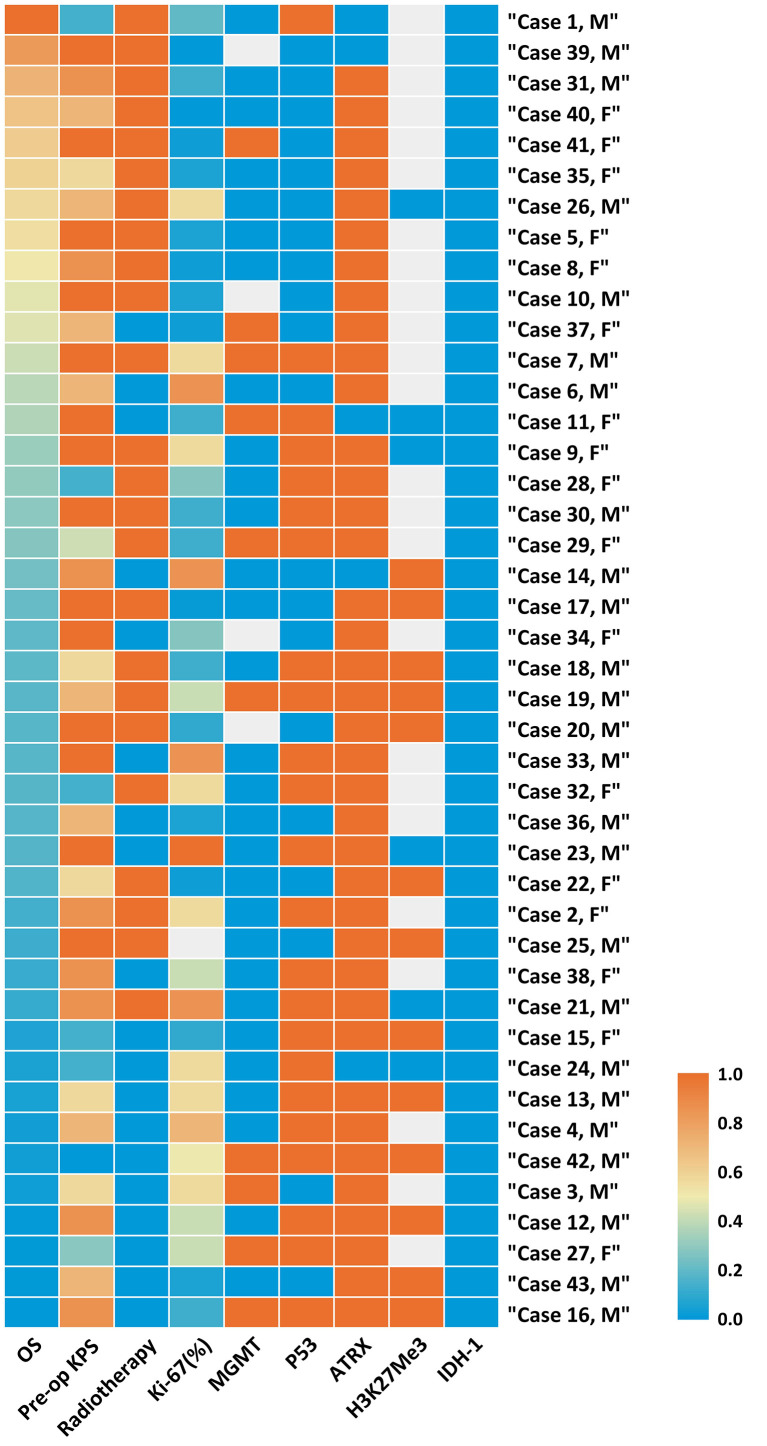
Heatmap of clinical and molecular features of 43 cases of Diffused Midline Glioma with H3K27M mutant. Each horizontal bar corresponds to a case and all aligned vertical bars across the variables correspond to the same case. The lowest value (0.0) in each column is blue, the highest value (1.0) in each column is red, while missing value is gray (see color scale). Different color densities represent the corresponding ratios. The first column order is arranged by OS decrement. Corresponding value in each cell could be referred in
Supplementary Table 1
.